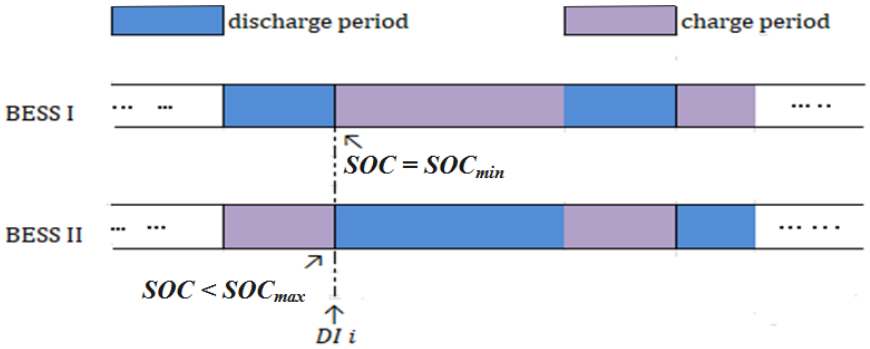
Figure 5. BESS’s simultaneous state exchange strategy [39].